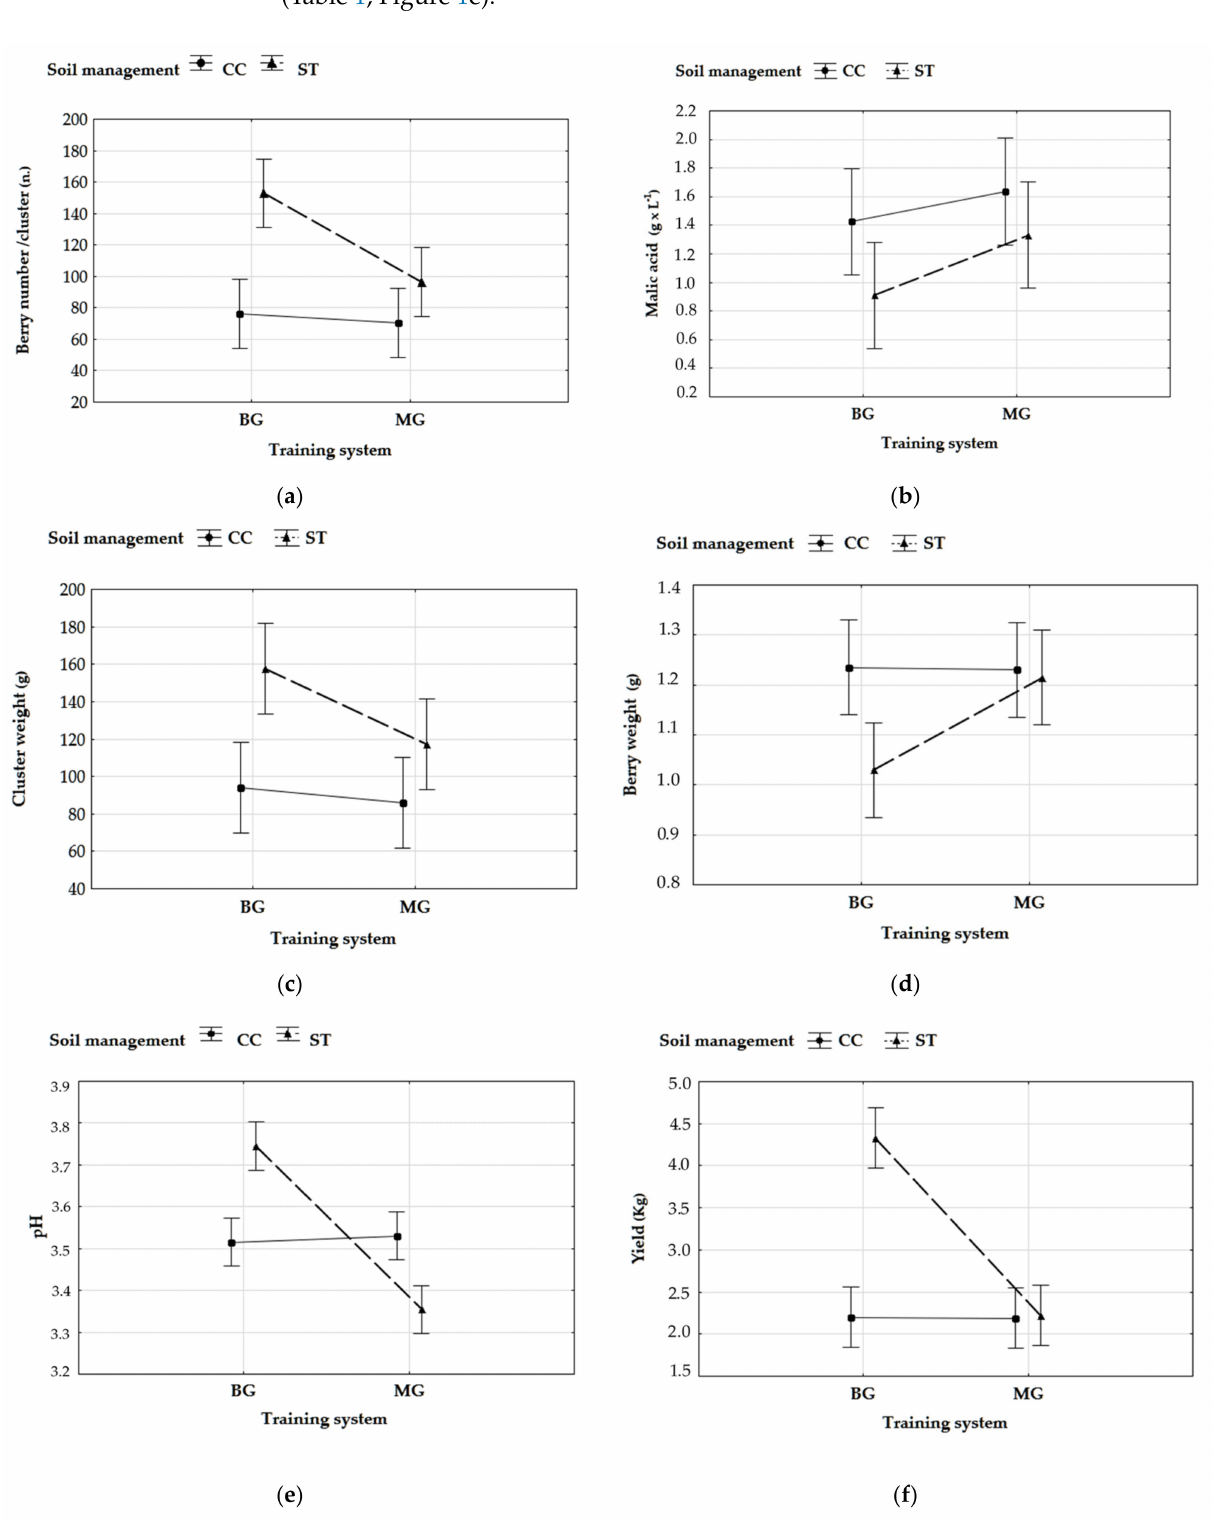
Figure 1. Significant interactions between soil management and training systems treatments on ( a ) berries number/cluster, ( b ) malic acid (g/L), ( c ) cluster weight (g), ( d ) berry weight (g), ( e ) pH, and ( f ) yield (kg/vine), ST: Soil tillage; CC: Cover crop. MG: monolateral Guyot; BG: bilateral